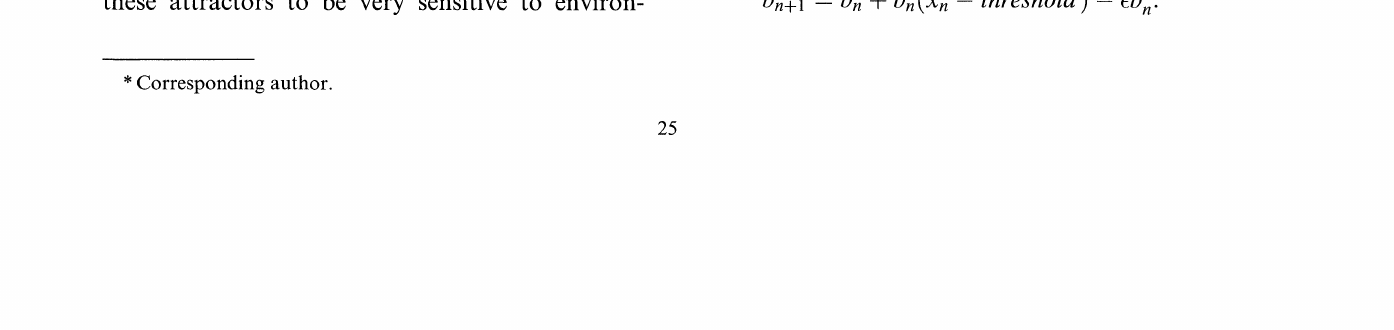
Figure illustrates the principle. A corresponding discrete equation is, for